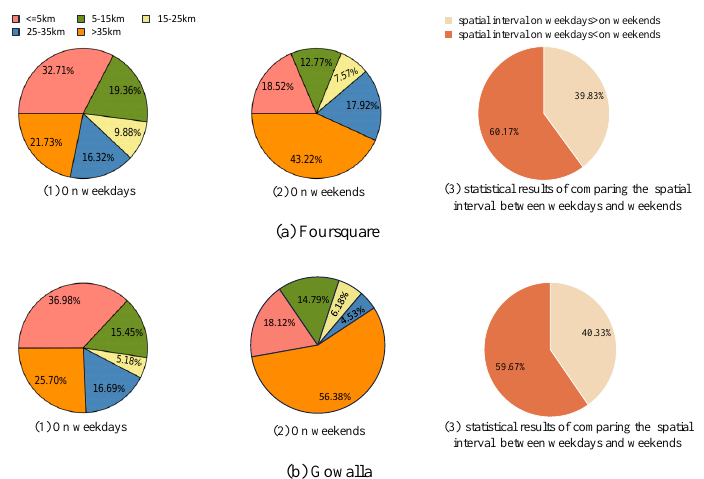
Figure 2. Illustration of spatio-temporal unequal interval relationship existing in users check-in data.